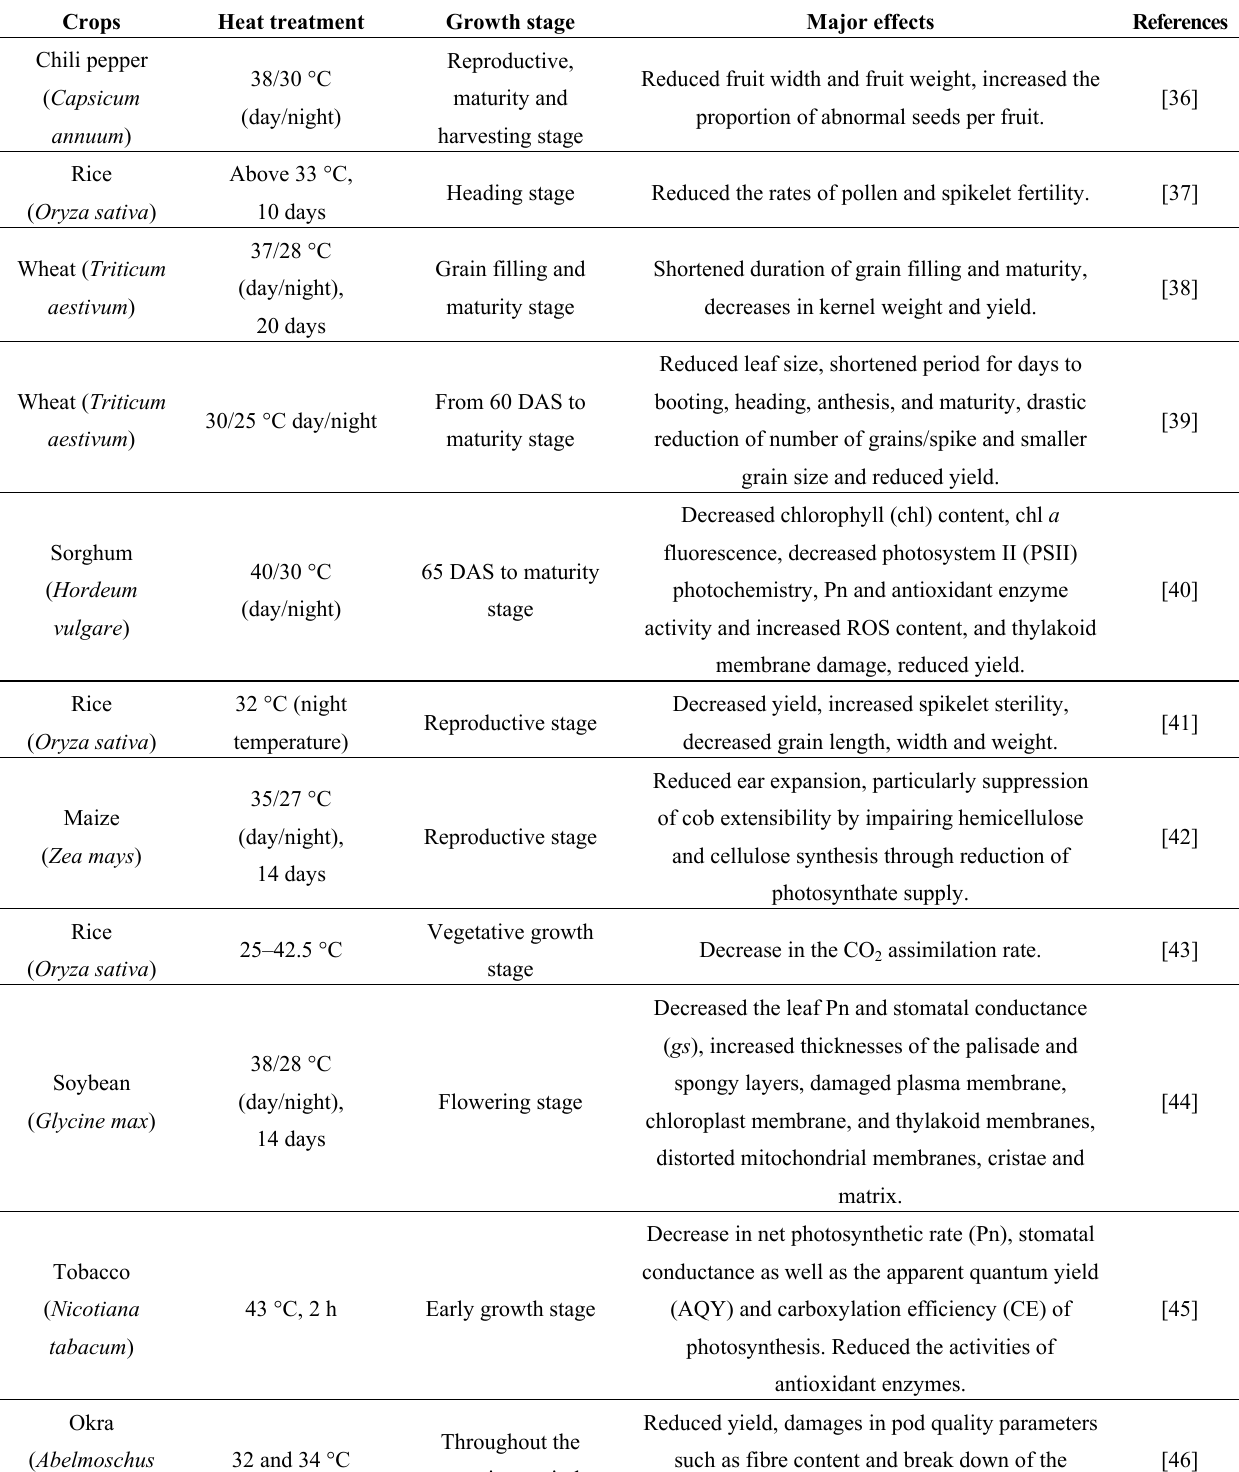
Table 1. Effects of high temperature stress in different crop